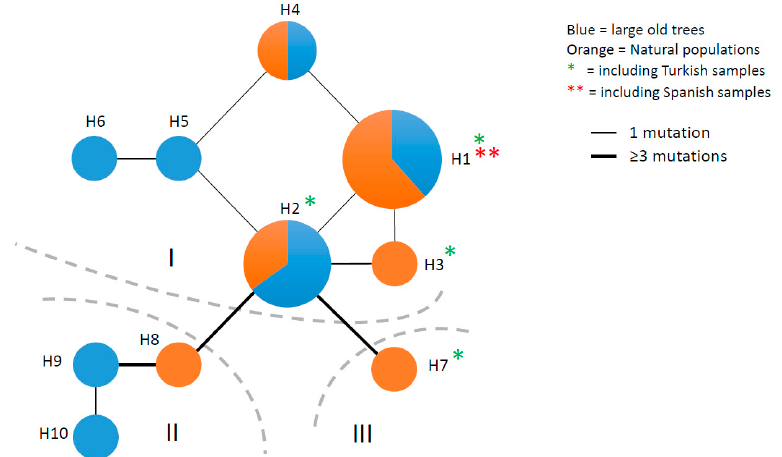
Figure 3. Plastid haplotype network of the combined trnH-psbA + trnK-matK regions in 47 chestnut trees (26 giant old trees + 21 ordinary trees from close-by natural populations). H1–H10: haplotypes; I, II and III: haplotype lineages. Haplotype size is proportional to the number of included samples; line thickness is according to the number of mutations separating each haplotype.